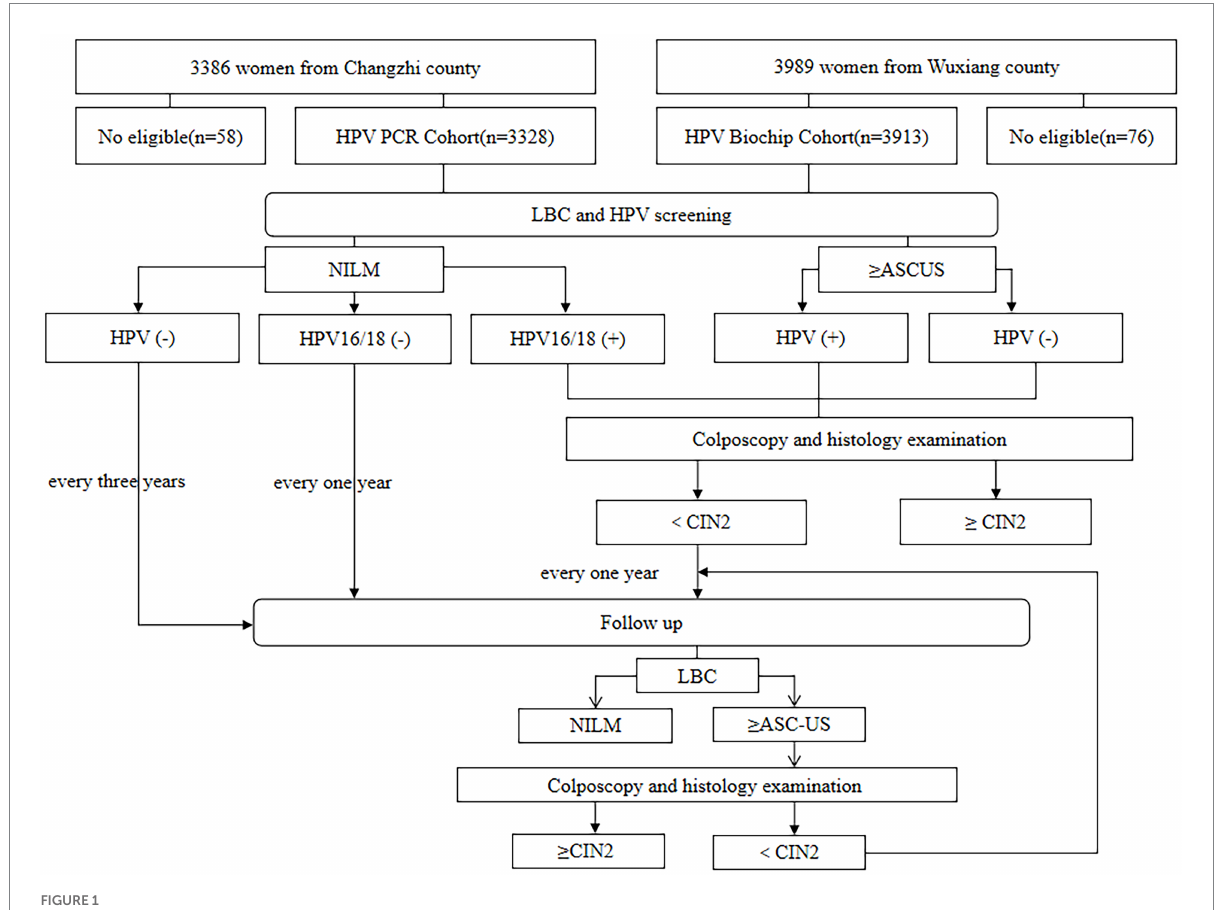
FIGURE 1 Flow chart of HPV PCR cohort and HPV biochip